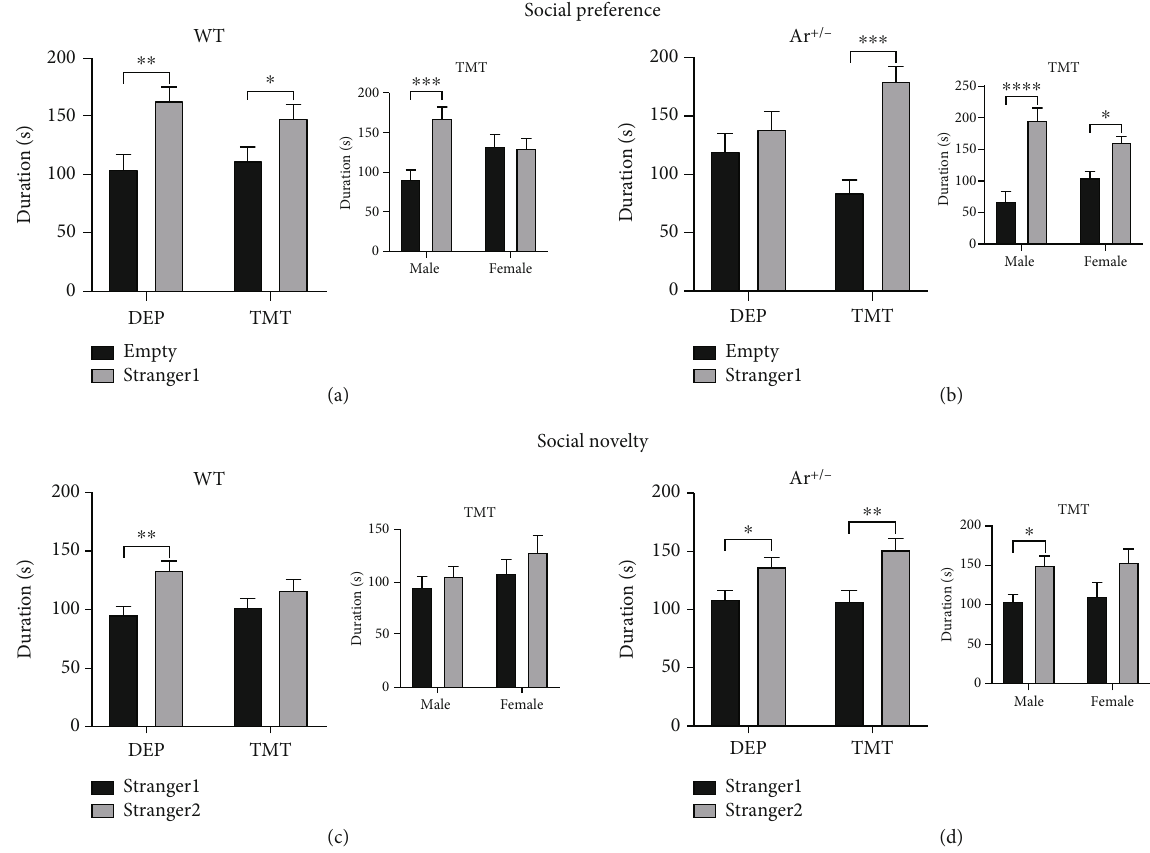
Figure 3: TMT-induced social preference and social novelty in the three-chamber social test. TMT exposure compromised the social preference (a) in the WT mice, particularly in females, as well as the social novelty (c). The Ar+/- mice after TMT exposure promoted the sociability (b) and social novelty (d), particularly in males. Data are expressed as mean ± SEM . ∗ P < 0 : 05 , ∗∗ P < 0 : 01 , and ∗∗∗ P < 0 : 001